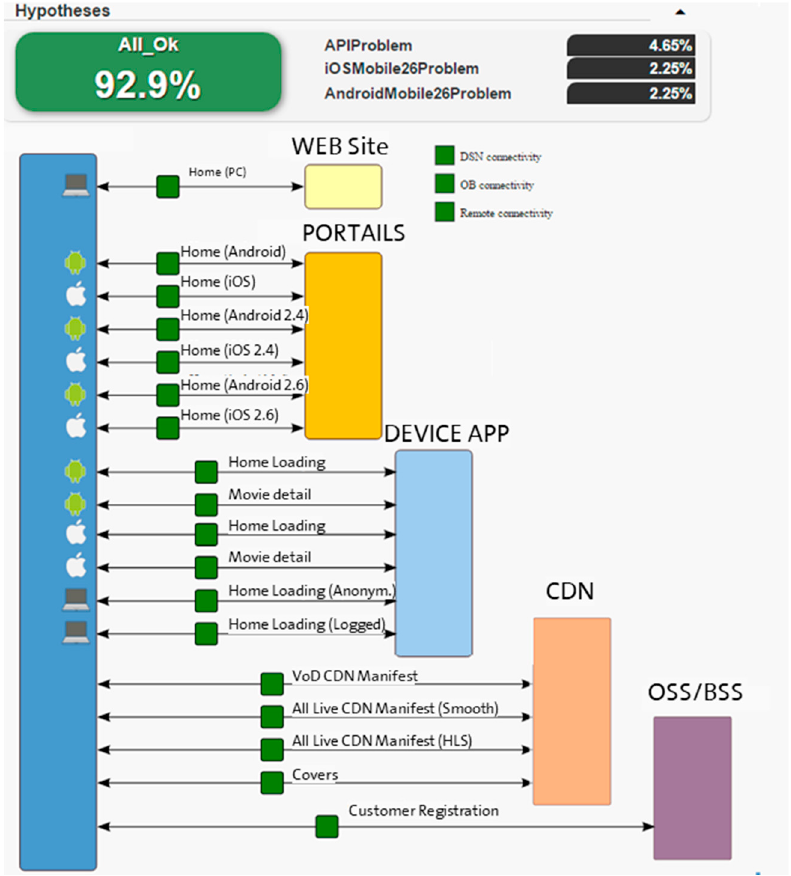
Figure 5. Diagnosis results graph.